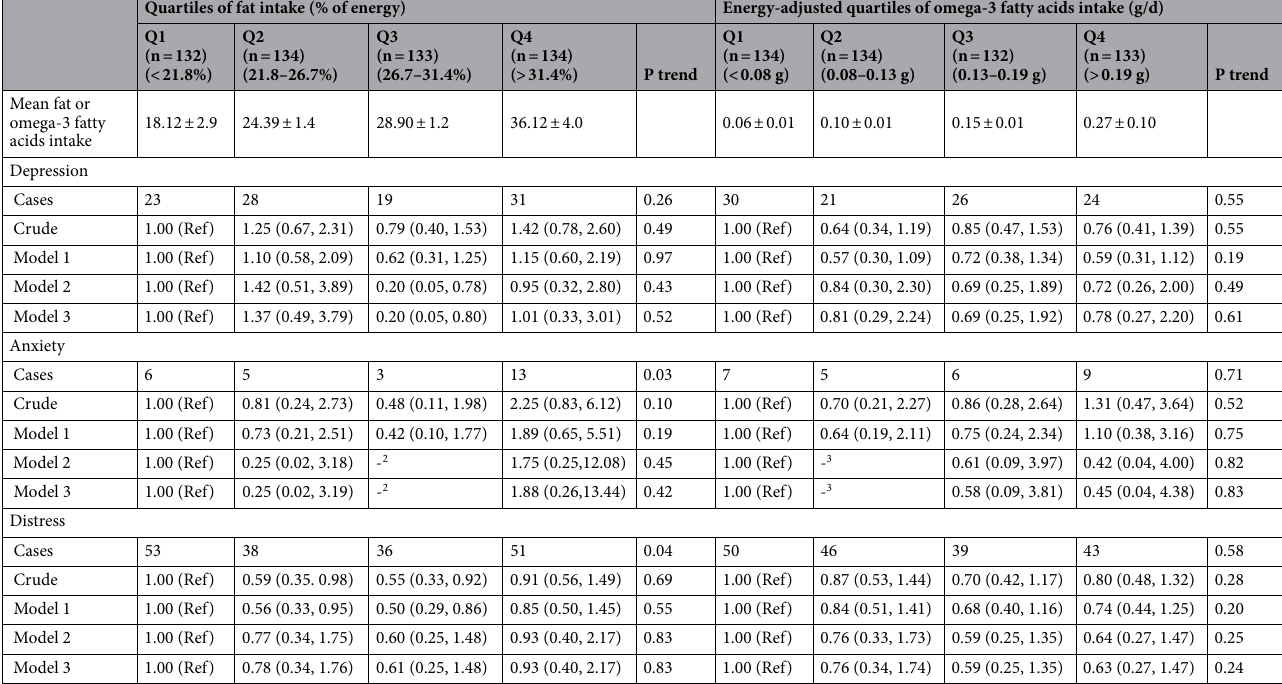
Table 3. Multivariate adjusted odds ratio (OR) and 95% confidence interval (CI) for mental disorders in quartiles of fat (as percentage of energy intake) and energy-adjusted omega-3 fatty acids intake a . a All values are odds ratios and 95% confidence intervals. P-trend was obtained by the use of fat or omega-3 quartiles as a continuous rather than categorical variable. Model 1: Adjusted for age, sex, and energy. Model 2: Additionally, adjusted for marital status, education, physical activity, smoking, hypertension, diabetes, taking anti-depressive drugs, taking dietary supplements (including vitamin D, omega-3, B complex, vitamin B1, B2, B3, B6, multivitamin, neurobion, calcium and iron) and socioeconomic status (SES). Model 3: Additionally, adjusted for body mass index (BMI). b OR (95% CI) could not be calculated, due to not having enough cases in this